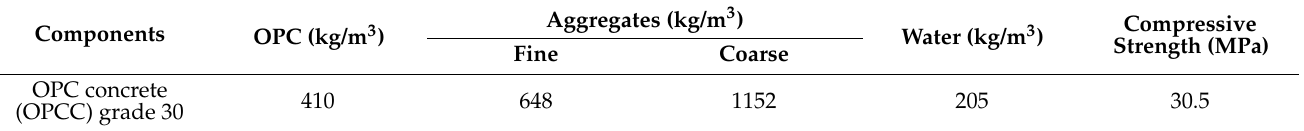
Table 2. Mix proportions and strengths of the OPC.